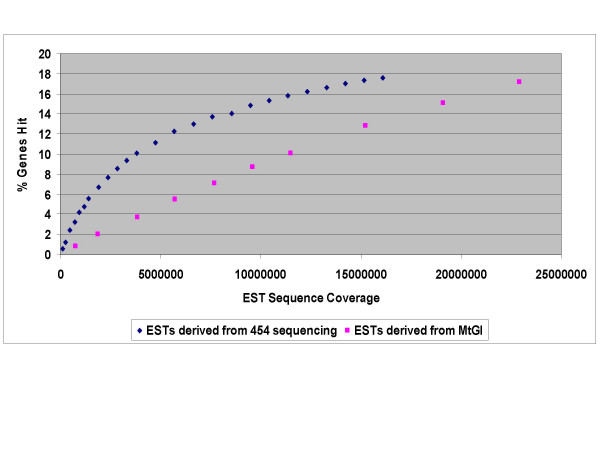
Gene discovery as a function of EST sequencing coverage.